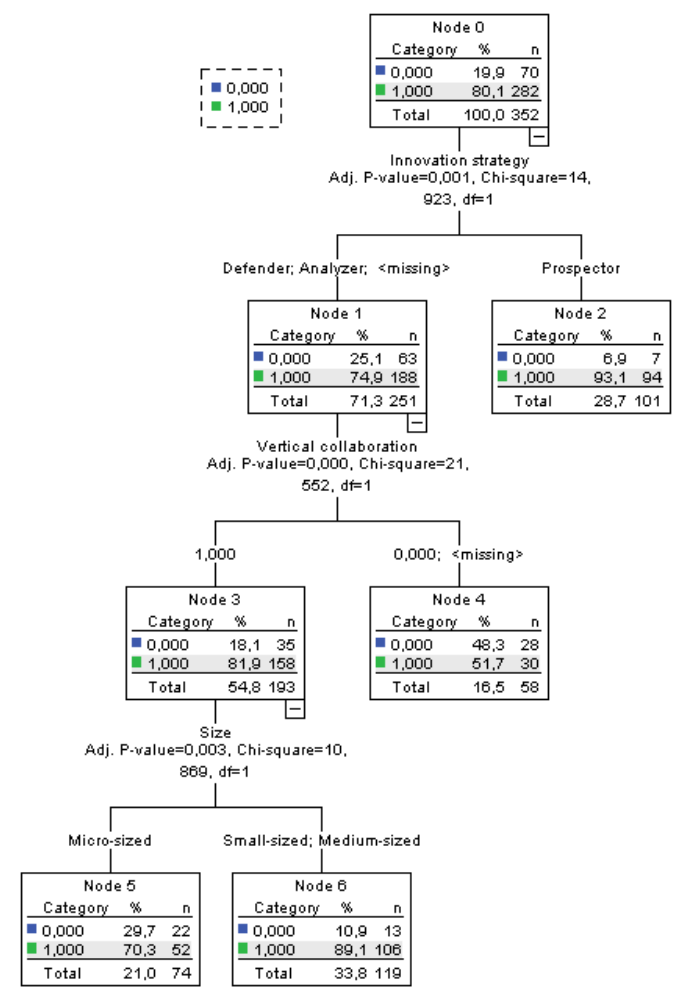
Figure 2. Determinants of innovation in